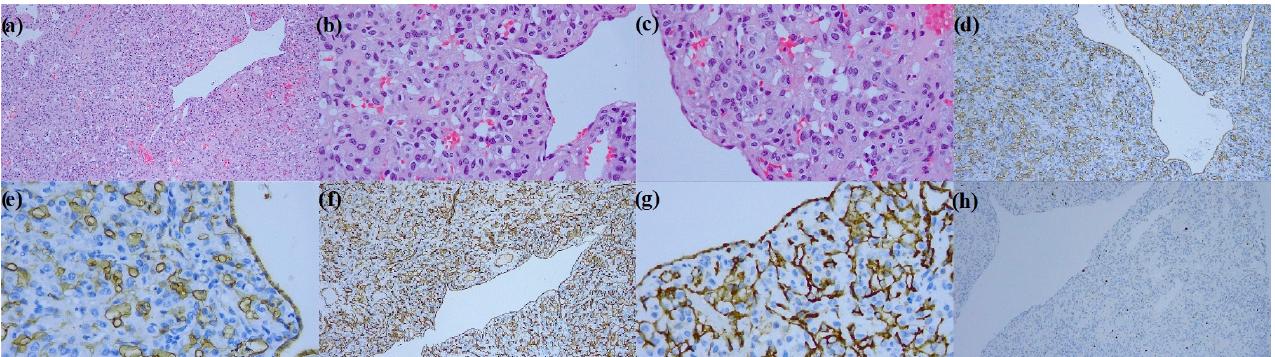
Figure 4. Pathology images: ( a – c ) hematoxylin and eosin stain: capillary hemangioma consists of small thin-walled vessels proliferation with lobular and solid growth patterns, dilated vessels, and more solid endothelial proliferation. Fibrosis, bland interstitial inflammation, and smooth muscle proliferation can be detected; ( d , e ) cytoplasmic immunoreactivity for CD31 in blood vessels and endothelial cells; ( f , g ) cytoplasmic immunoreactivity for CD34 in vessels layers and solid endothelial proliferation; ( h ) scattered nuclear positivity for ki67 in endothelial cells, very low proliferation rate is observed.